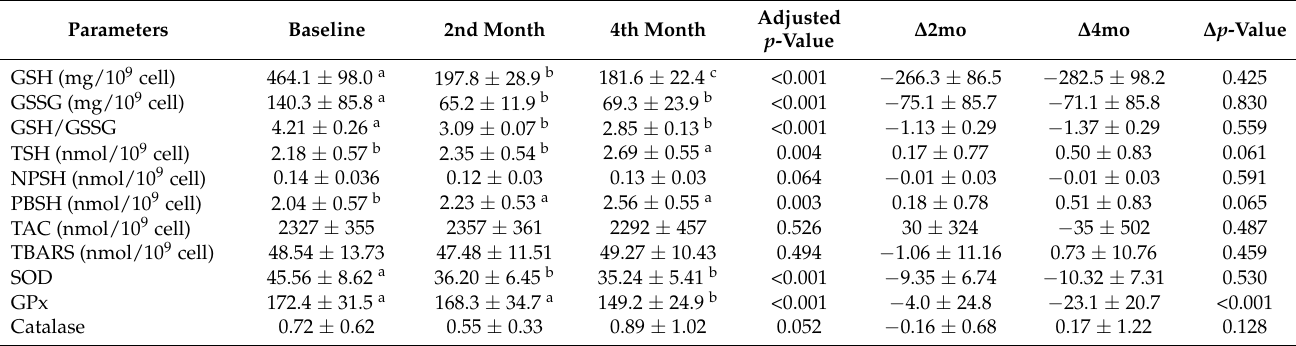
Table 4. Erythrocyte contents of antioxidant indices, lipid peroxidation product and antioxidant enzyme activities. Parameters